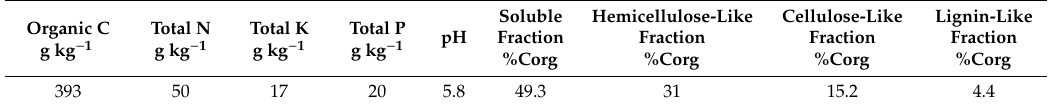
Table 1. Chemical characteristics of frass (data from Houben et al.